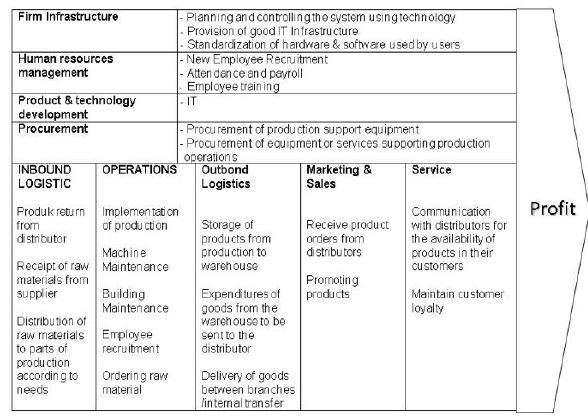
Figure 3: Diagram of Value Chain Analysis of Pharmaceutical Com- pany